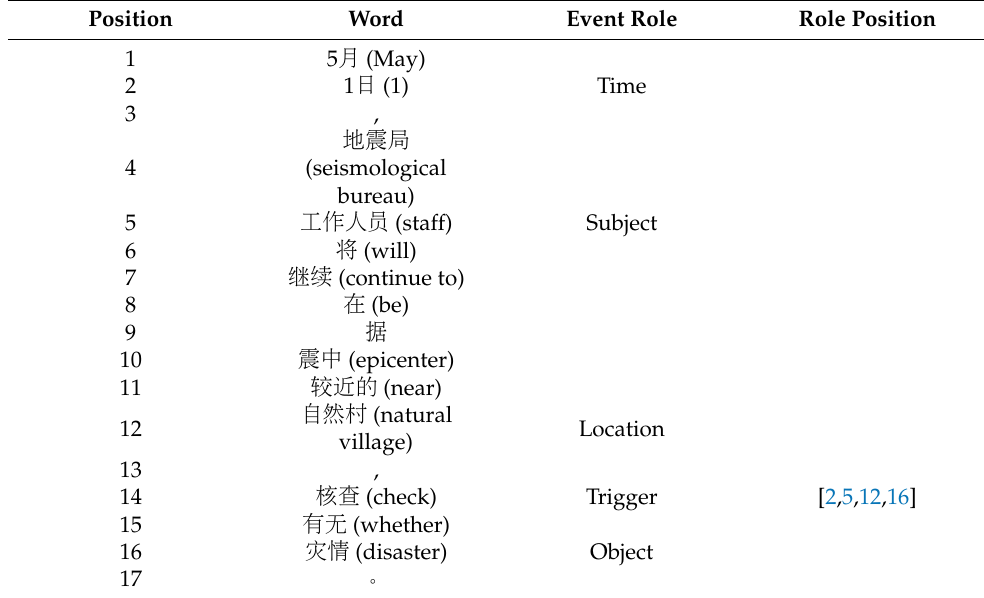
Table 3. Event Role